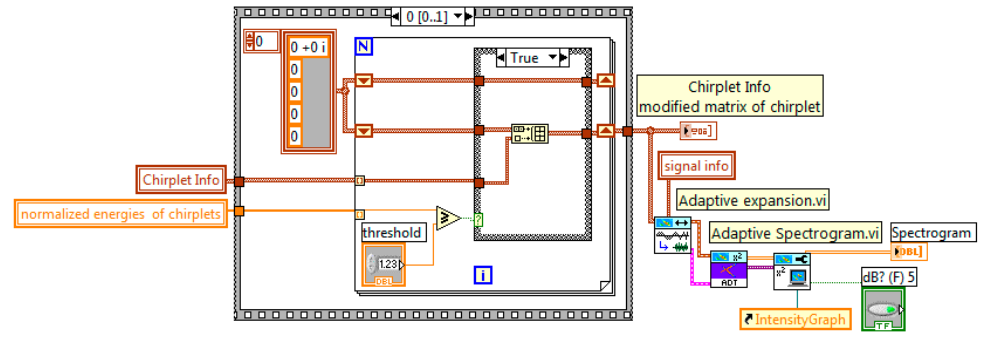
Figure 11. The part of the block diagram of the virtual analyzer that modifies the matrix of the chirplet parameter and computes the modified adaptive spectrogram.